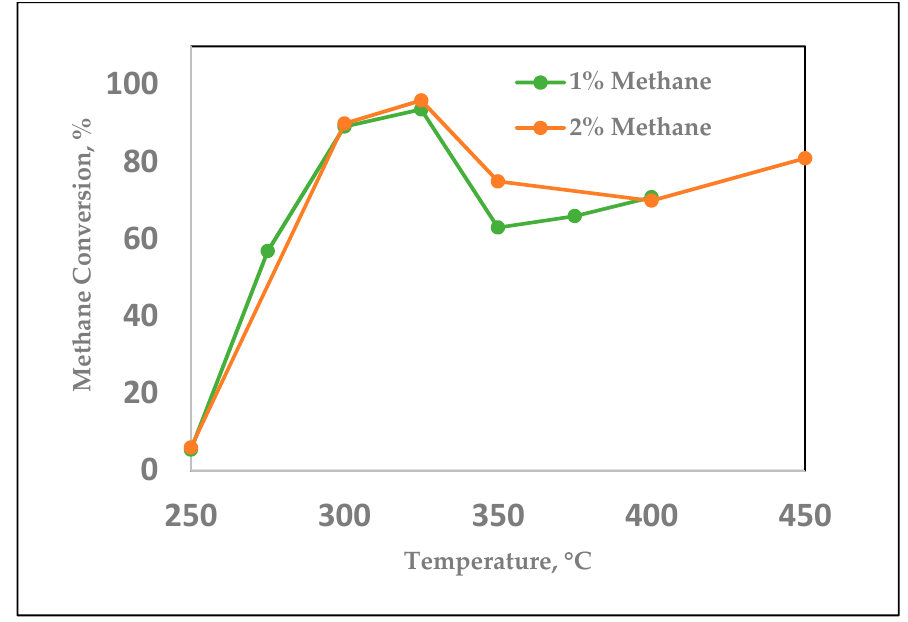
Figure 11. Activity of the catalyst at different temperatures.